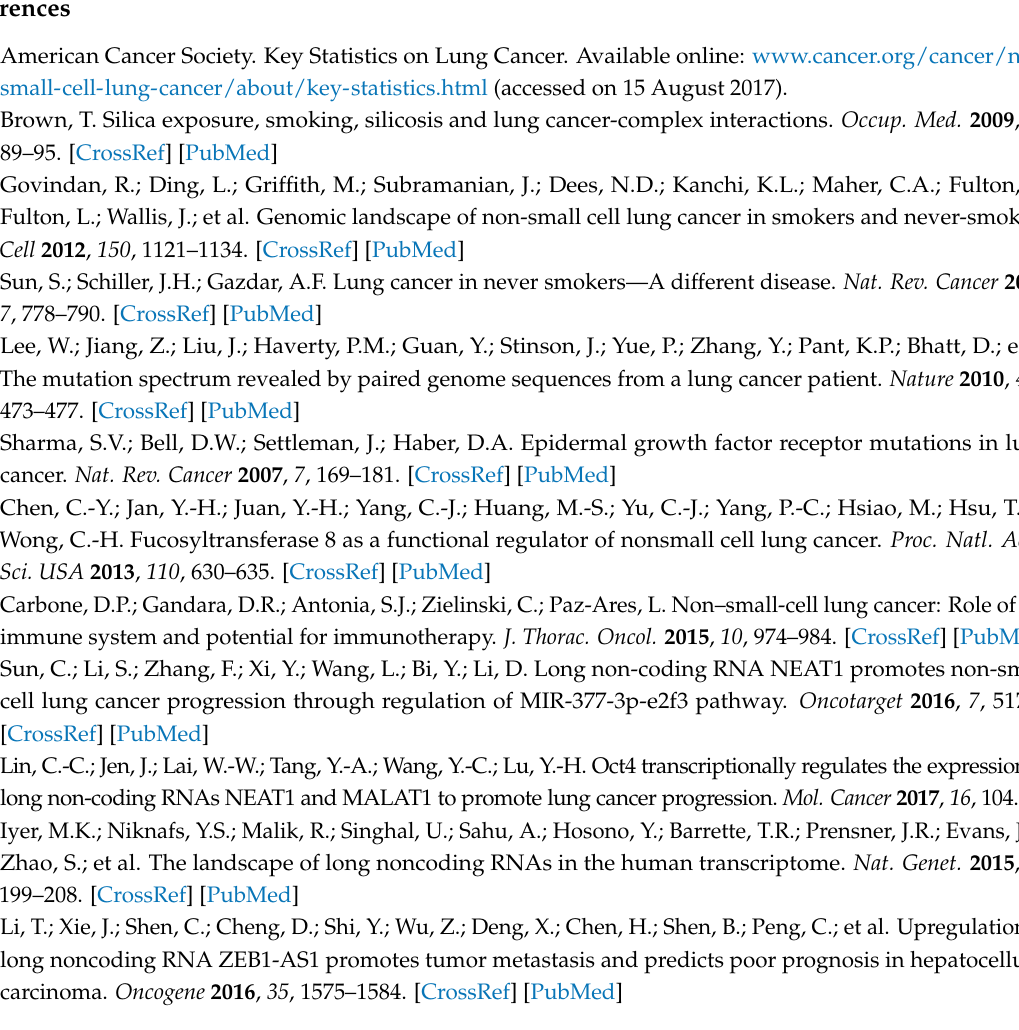
Figure S1: The regulatory networks contained lncRNAs. (a) The percentage of lncRNAs in the networks. Network 10 appeared to contain the highest number of lncRNAs compared to the other networks. The lncRNAs were absent in five networks: 3, 4, 6, 12, and 15, respectively. (b) Network 11 contain only one lncRNA (blue) LINC01614, a known lung cancer lncRNA. The yellow box, RUNX2, is a key TF harboring lung cancer driver somatic mutation. TFs often regulate multiple genes in the network. For instance, the purple-colored nodes are potential target PRRX1 genes. The purple circles represent the target PRRX1 genes reported by Marbach et al.; whereas, the purple diamonds represent the PRRX1 target genes identified by Bayesian network analysis. Figure S2: The number of significantly connected networks of mutated 63 TFs outside networks. Figure S3: The expression correlation of the key lncRNAs and the putative target genes in 16 solid-tissue cancer types. Table S1: The significantly enriched pathways of 15 gene regulatory network in lung adenocarcinomas. Table S2: The RNAseq of 53 human tissues used by GTEx